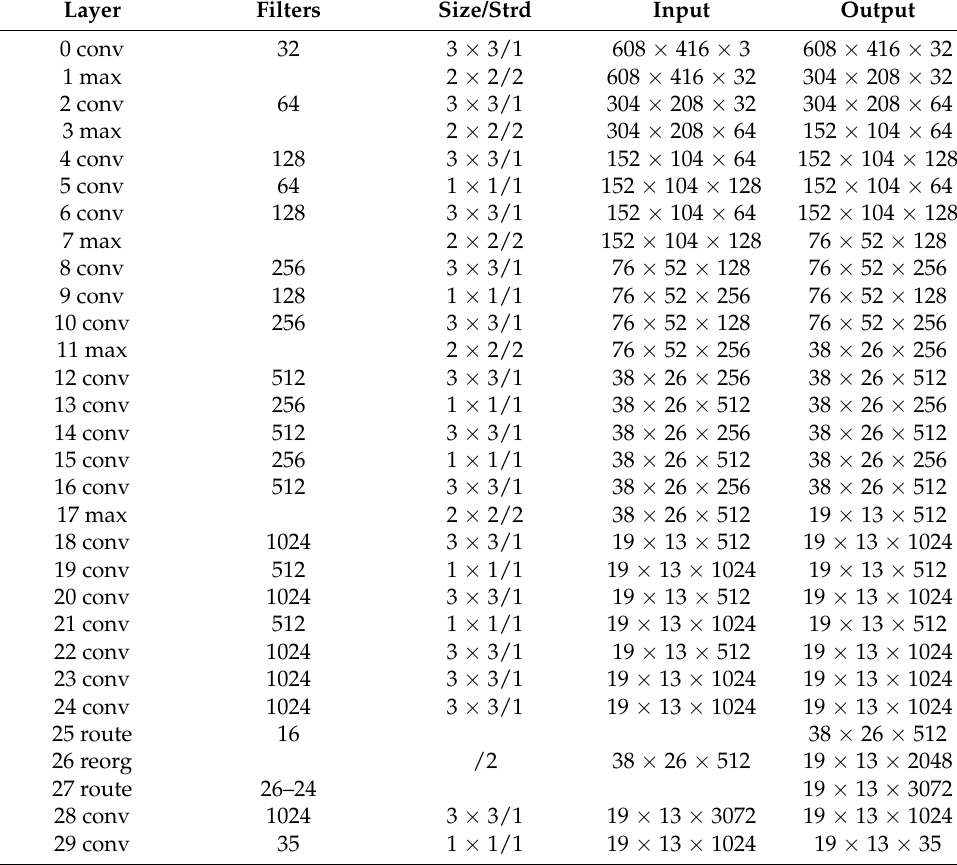
Table 2. Vehicle detection model architecture.